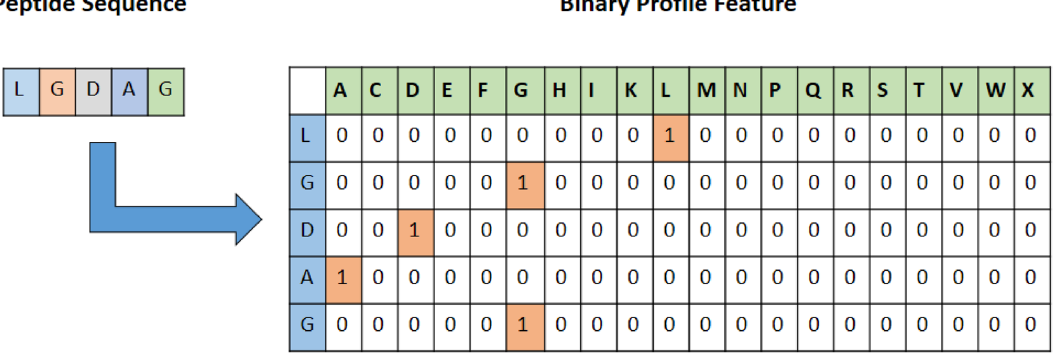
Figure 2. Binary profile feature generation of peptide